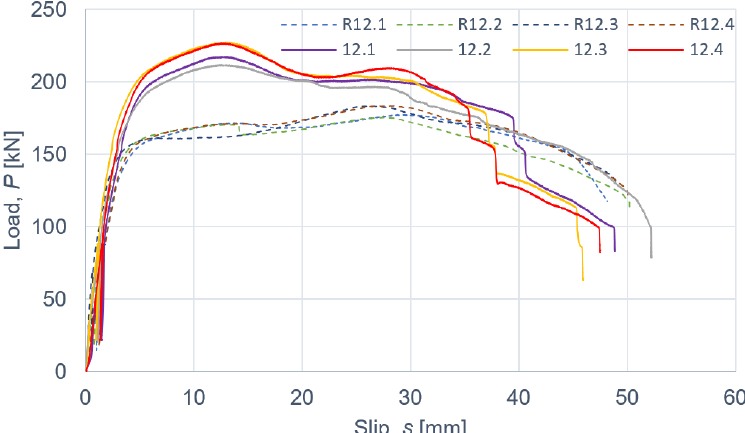
Figure 7. The load–slip curves from the push-out tests of the shear connections with 10 mm screws and with toothed-plate connectors (type C2-50/M10G, Bulldog) in specimens 10.1–10.4 or without toothed-plate connectors in specimens R10.1-R10.4.